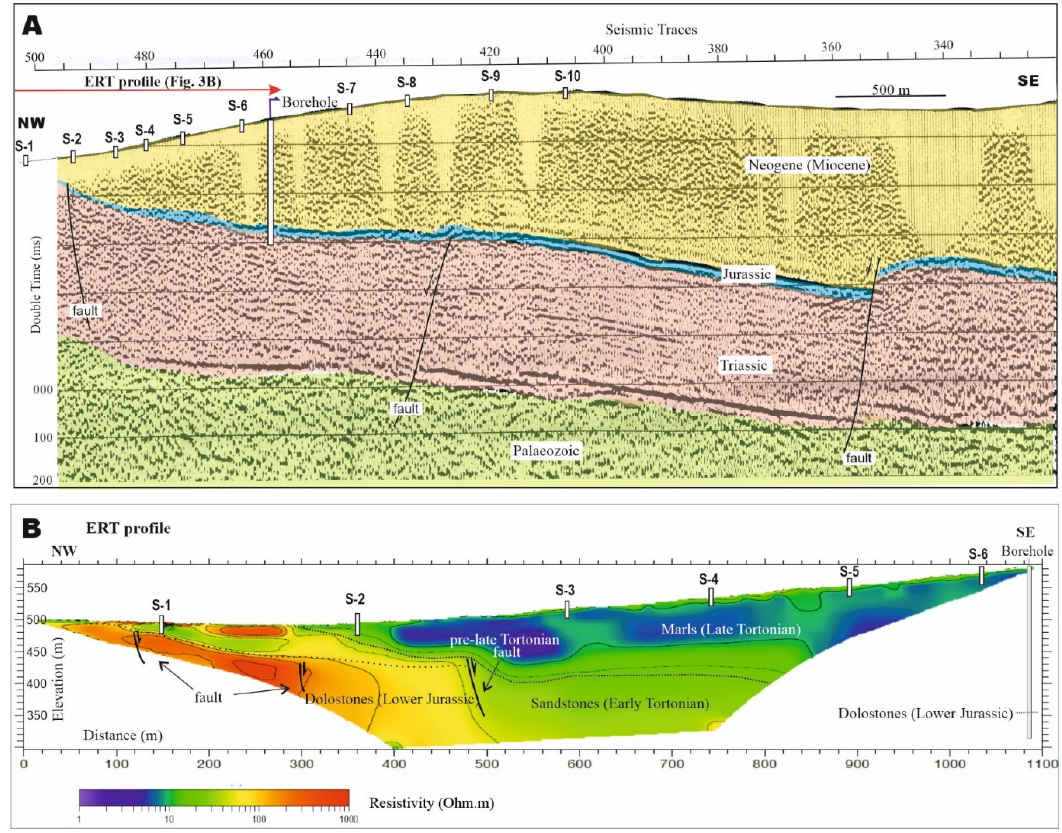
Figure 3. Seismic reflection profile and interpretation (see location in Figure 2). The positions of the pumping boreholes and the TDEM (S1 to S10) measuring stations are indicated. M.a.s.l. (metres above sea level) ( A ). Electrical resistivity tomography (ERT) profile ( B ).